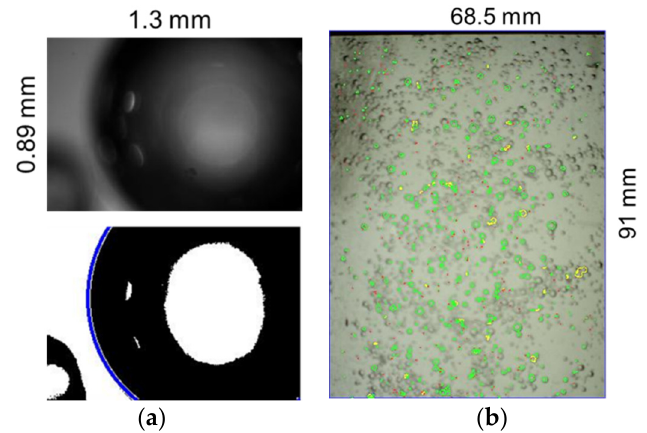
Figure 7. Field of view of PVM ( a ) and APBS ( b ) cameras.